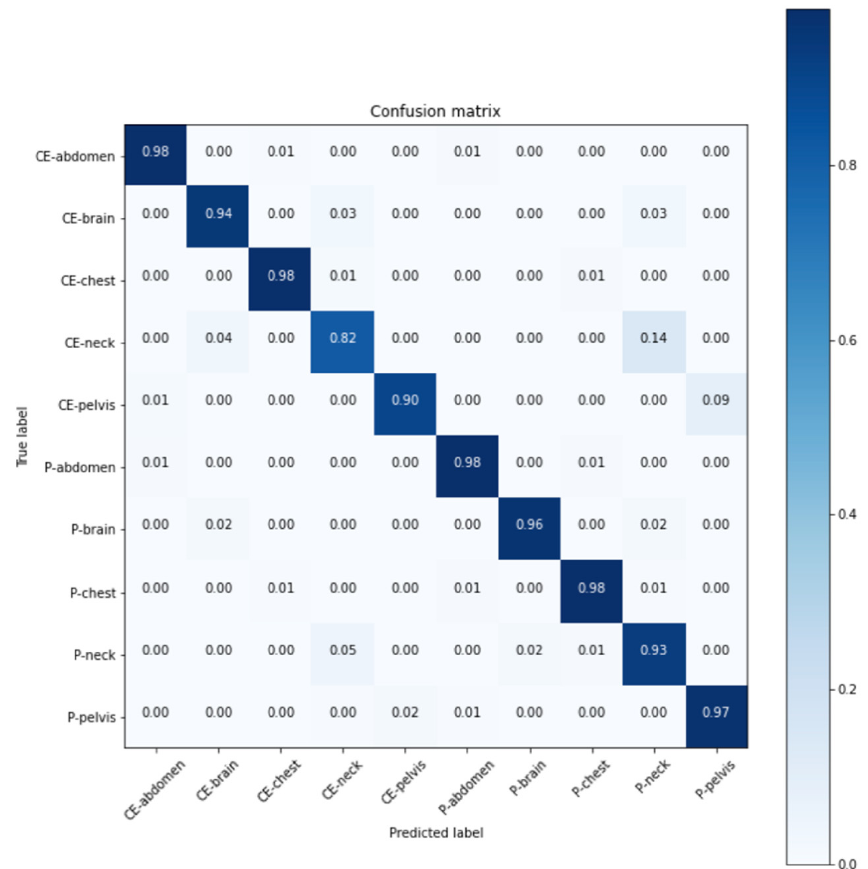
Figure 9. Confusion matrix of A1-7. (CE: contrast-enhanced, P: plain).